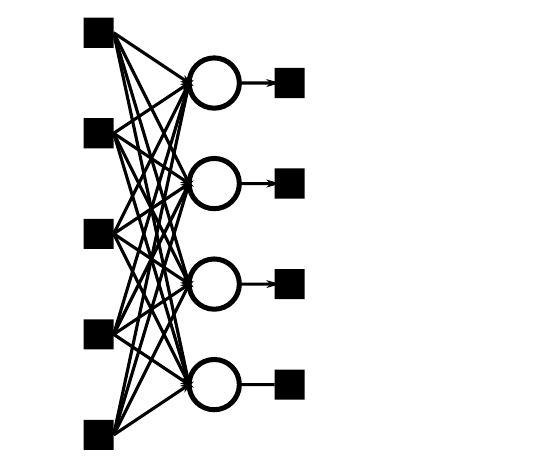
Figure 4. A fully connected layer with C i = 5 and C o = 4.